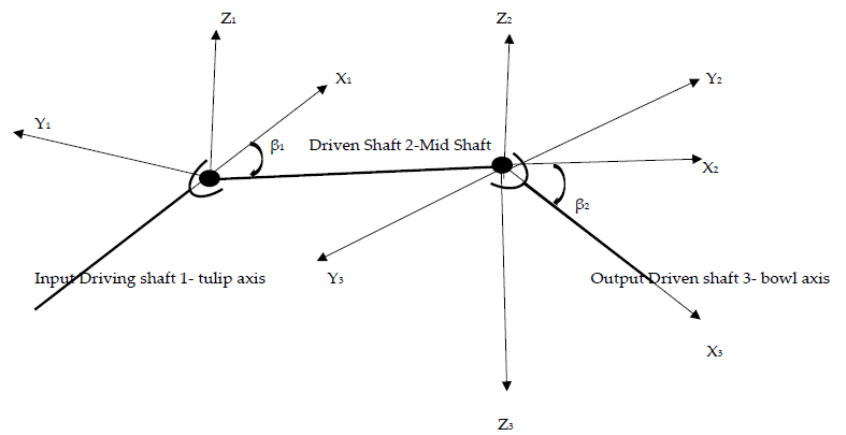
Figure 5. Schematic representation of an automotive driveshaft using 3 cartesian systems of coordinates.